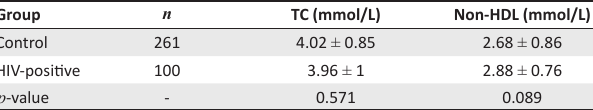
TABLE 1: Comparison of total and non-high-density lipoprotein cholesterol in HIV-positive patients and HIV-negative controls, Julia Molefe Clinic,